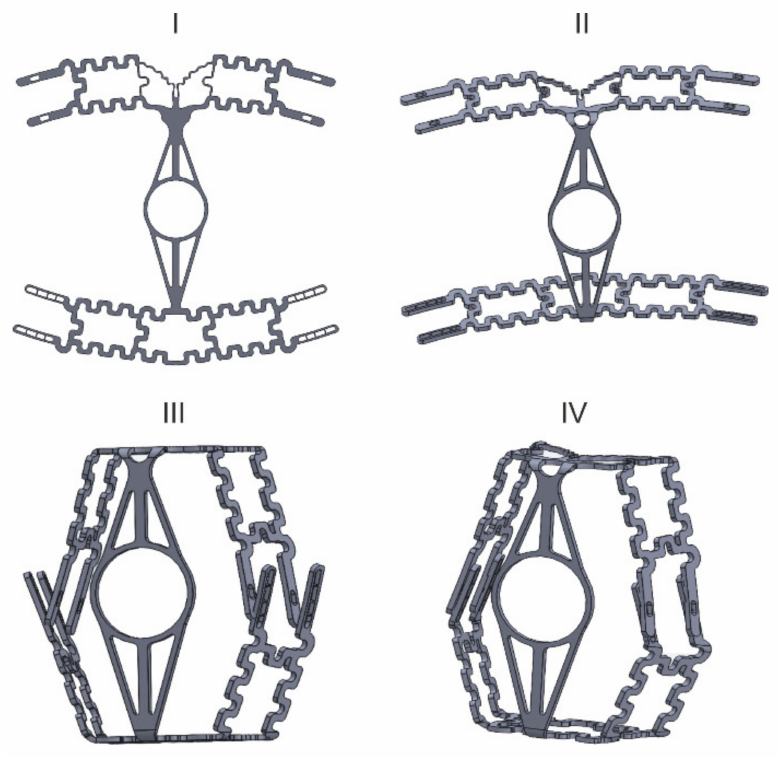
Figure 5. Frame assembly stages: I–IV are an order of elements